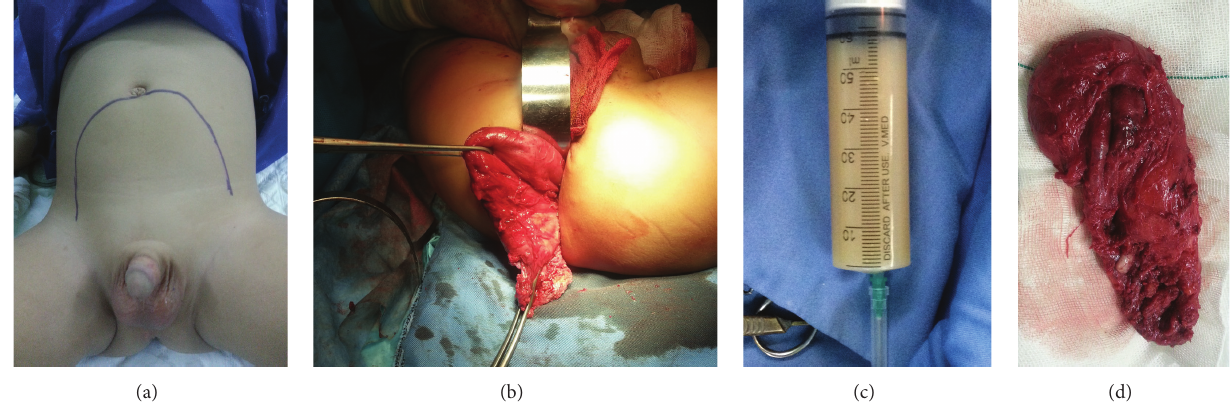
Figure 2: (a) Tumor extension. (b) Tumor resection through the posterior sagittal incision. (c) Turbid fluid withdrawn from the cystic component of tumor. (d) Gross appearance of the